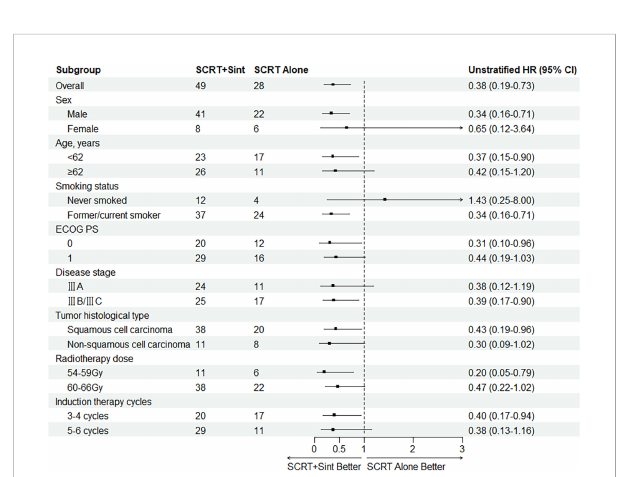
FIGURE 3 Subgroup analysis of PFS. SCRT, sequential chemoradiotherapy; Sint, sintilimab; ECOG PS, Eastern Cooperative Oncology Group Performance Status.